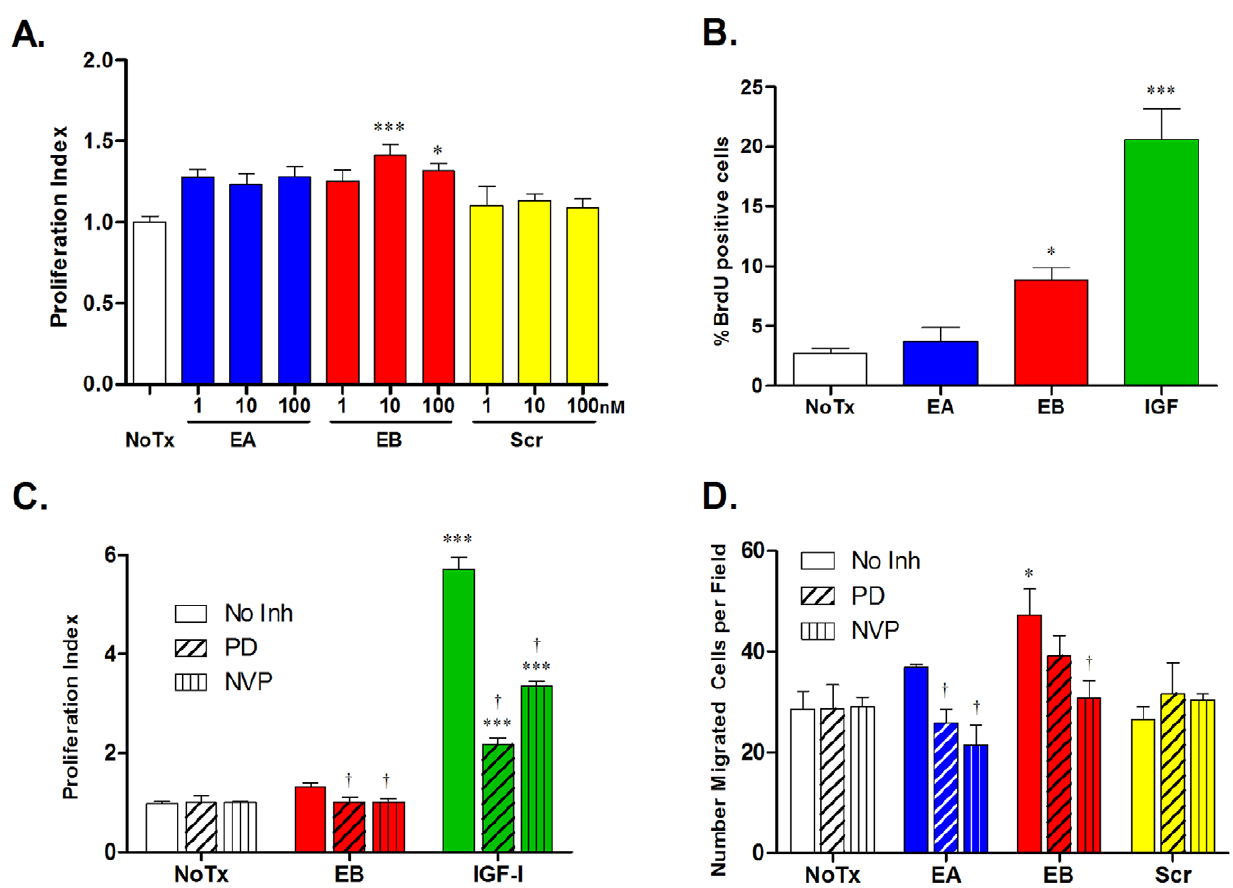
Figure 6. EB increases in myoblast proliferation and migration are MAPK and IGF-IR signaling dependent. A . C2C12 cells were plated in 96 well plates, starved for 6 hours, and treated with synthetic E-peptides. A BrdU plate assay was used to quantify proliferating cells, where increased absorbance is correlated with increased proliferation. Bars represent means 6 s.e.m. of N=10 wells. B . A similar BrdU assay was used to visualize the proliferating cells on slides. Cells were treated as above (EA and Scr 100 nM, EB and IGF 10 nM), fixed, and stained with BrdU and DAPI. Total cells and proliferating (BrdU positive) cells were counted from 3 10 6 fields for each slide, and bars represent means 6 s.e.m. of N=5 slides. For A and B, *, p , 0.05; ***, p , 0.001 for comparisons to NoTx via 1-way ANOVA followed by a Tukey post-hoc test. C . C2C12 cells were tested as in A, except an inhibitor of MEK, PD 098059 (PD, 50 m M) or IGF-IR (NVP, 100 nM) was included in the cell media. Bars represent means 6 s.e.m. of N=18 wells for No Inhibitor (No Inh) and N=8 for with inhibitors. D . C2C12 cells were plated in the upper chamber of 24-well plate trans-well migration inserts in 0% serum media. Cells were allowed to migrate for 5 hours and stained with DAPI, imaged and counted. Synthetic E-peptides (100 nM) were added to upper and lower chambers with or without inhibitors (PD 50 m M, NVP 100 nM). Images were taken as in B, and bars represent means 6 s.e.m. of N=4 slides. For C and D, *, p , 0.05; ***, p , 0.001 for comparisons to NoTx via 2-way ANOVA followed by a Bonferroni post-test. { , p , 0.05 for comparisons to No Inh via 2-way ANOVA followed by a Bonferroni